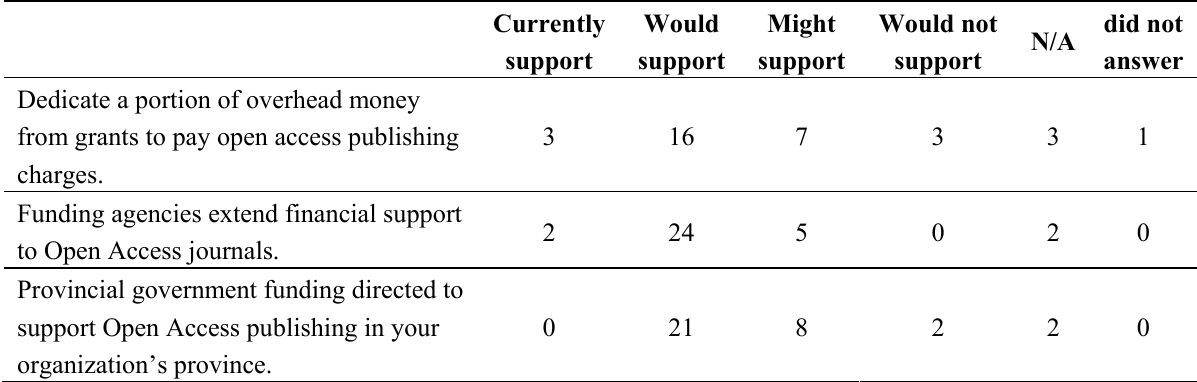
Table 2. Level of external support for OA publishing and Canadian academic journals.